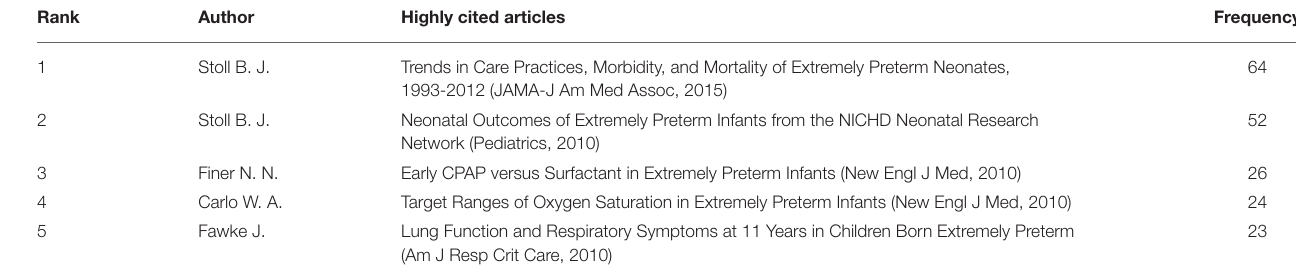
TABLE 4 | Top 5 high cited articles related to BPD in extremely pre-mature